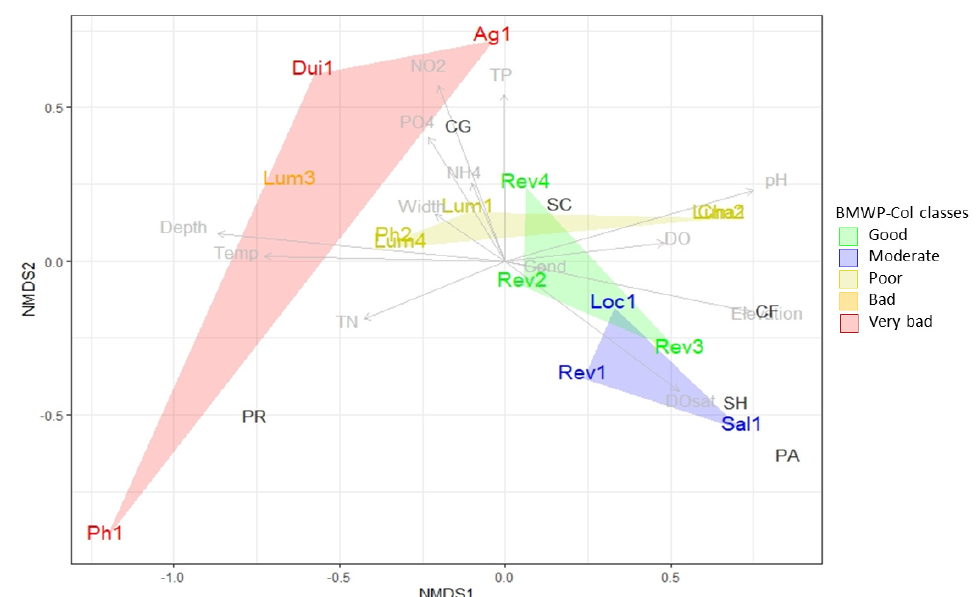
Figure 3. Non-metric multidimensional scaling (NMDS) diagram of freshwater rivers within Coca River basin (CRB) and Aguarico River basin (ARB) sampled in June 2014. The associations between the sites with the same classes of the BMWP-Col index are shown in colours, according to their water quality. The main physical-chemical and two hydromorphological representative variables are indicated in grey letters (see Table 1). FFG are represented in black letters, where PA = parasites, CF = collector-filterers, SH = shredders, SC = scrapers, PR = predators, and CG = collector-gatherers.